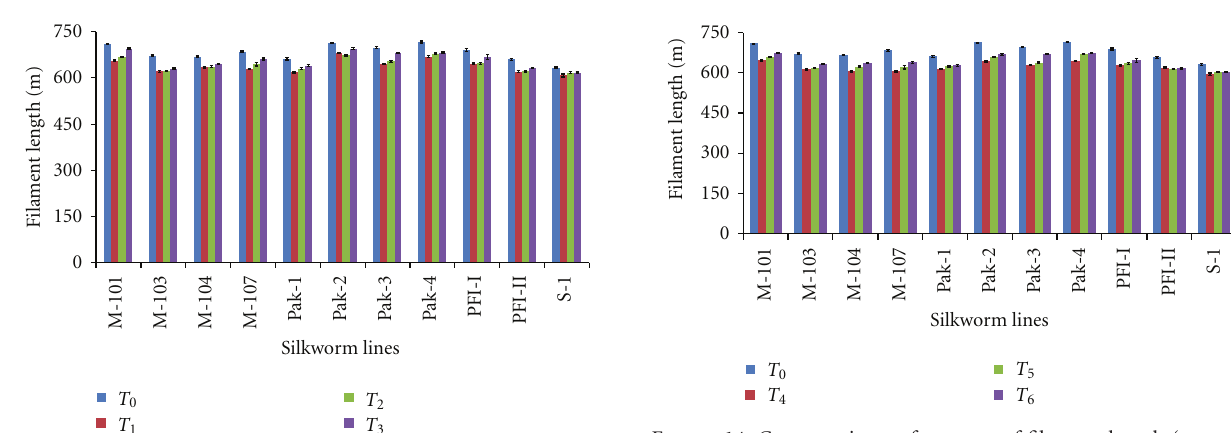
Figure 14: Comparative performance of filament length (mean ± SE) of eleven silkworm lines at 30 ± 1 ◦ C in combination with 55, 65, and 75% RH and controlled conditions of temperature and RH (25 ± 1 ◦ C and 70–80%, resp.).